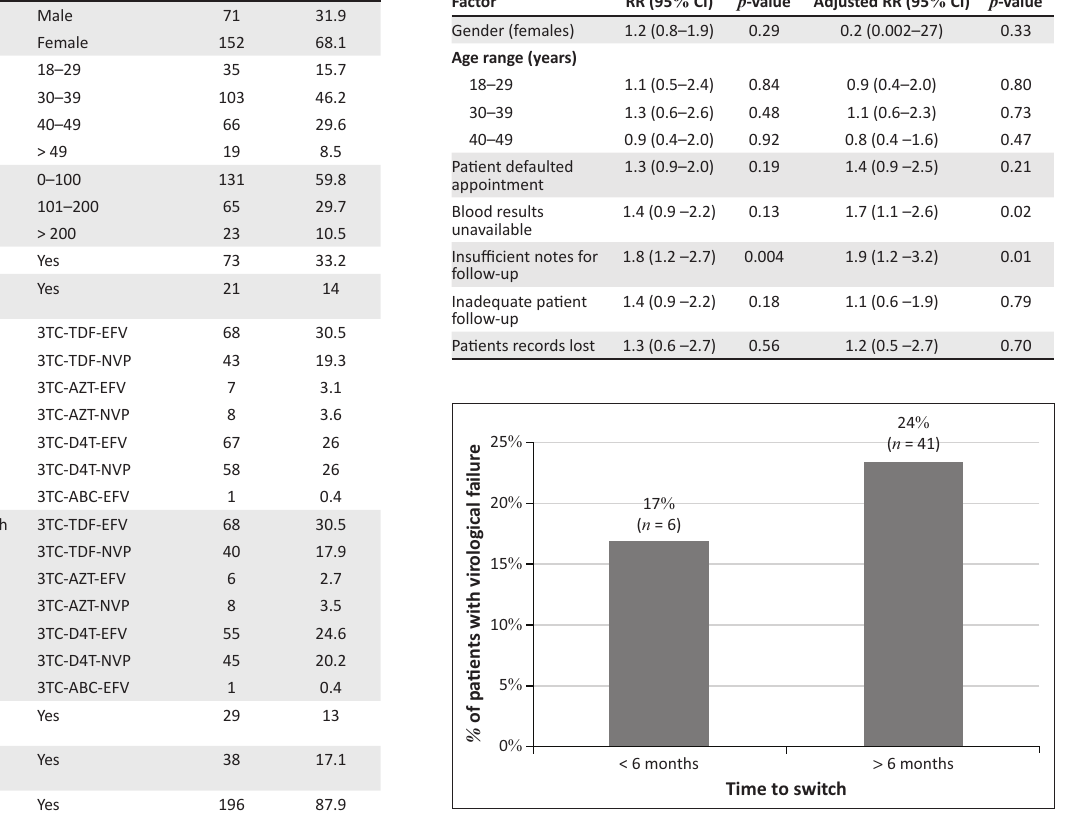
FIGURE 2: Virological failure among patients switched to second-line antiretroviral treatment at an antiretroviral clinic in eThekwini health district, 2011 to 2014.